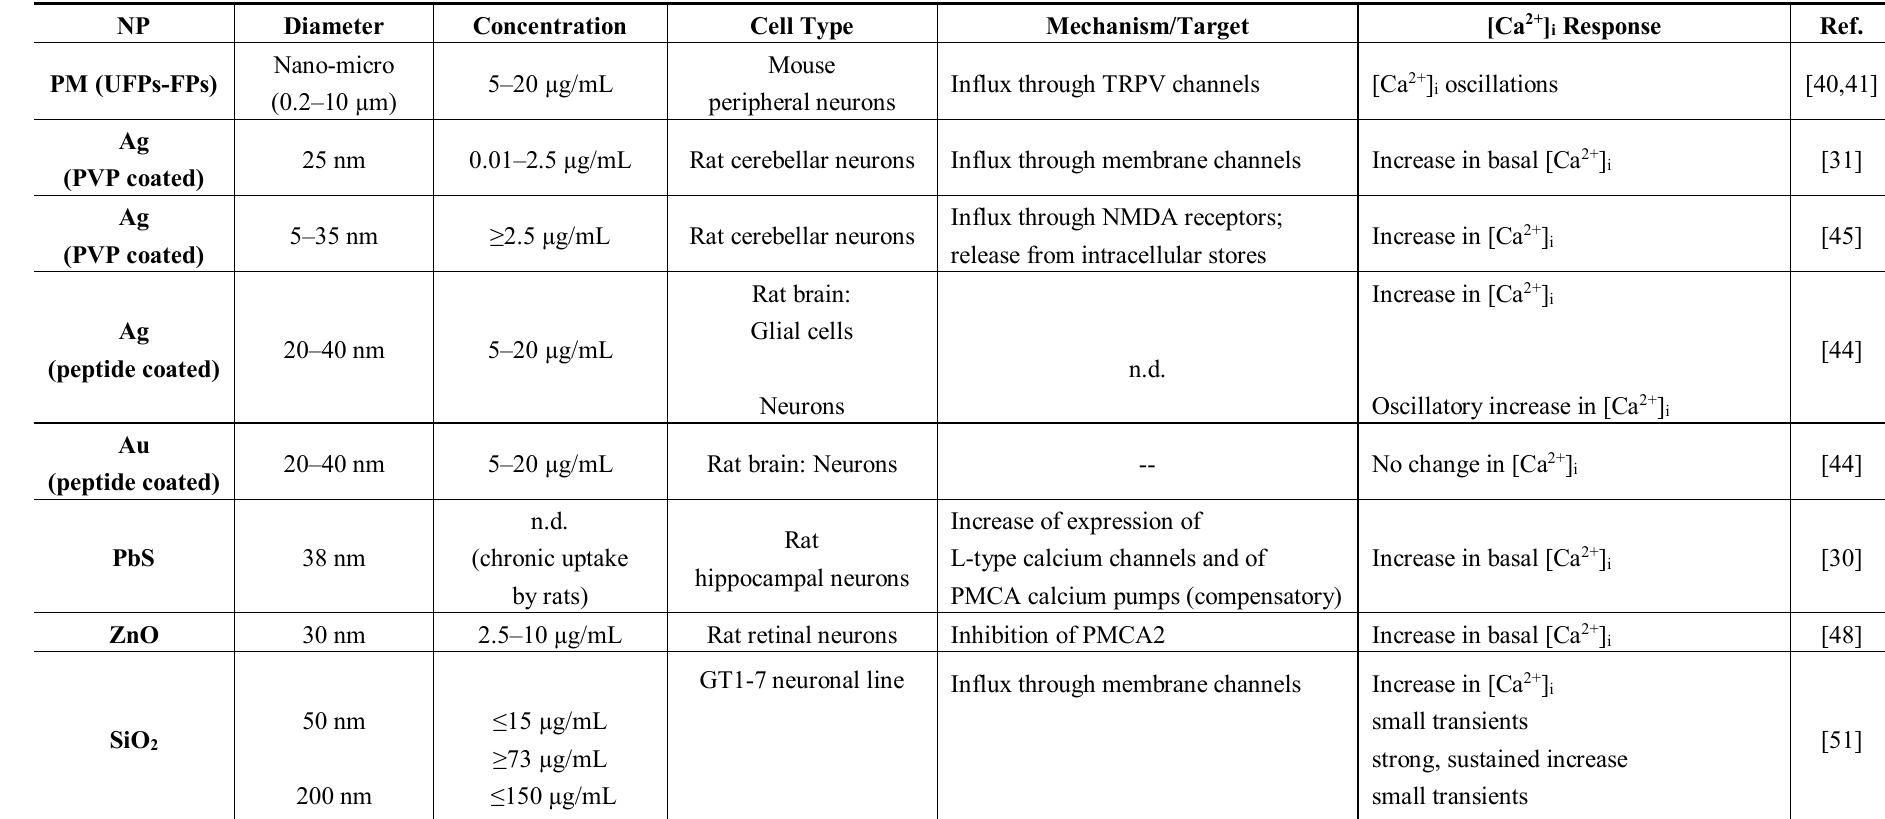
induced by different classes of NPs in neuronal i